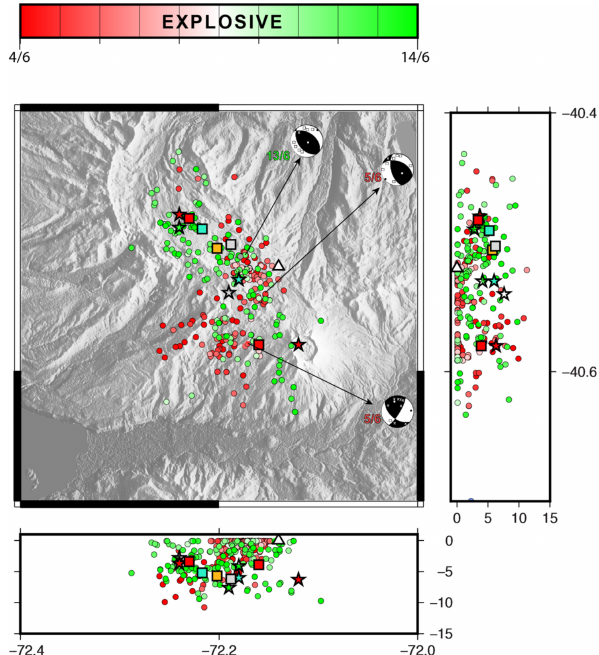
Figure 6. Relocations of seismicity recorded before eruption onset during the final unrest phase. See the caption of Fig. 5 for an expla- nation of symbols and colors.